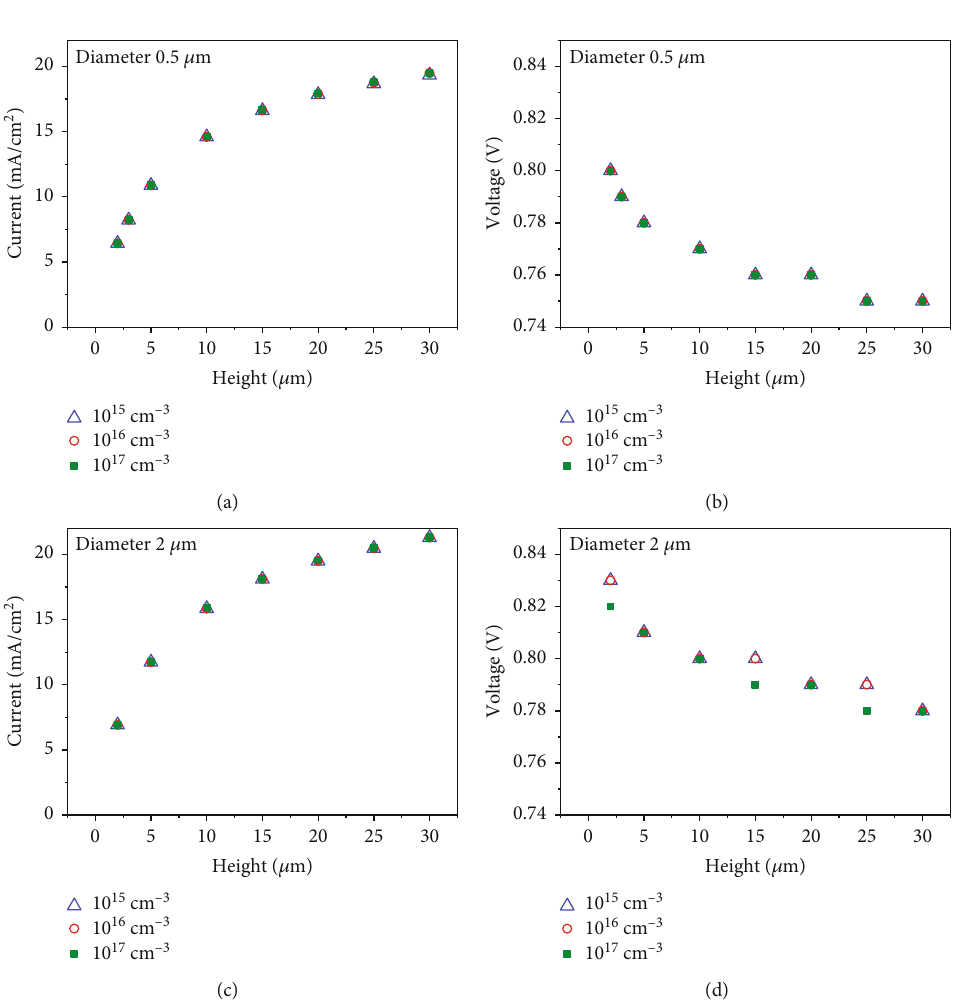
Figure 4: Calculated values of (a, c) J SC and (b, d) V OC for the bottom junction as a function of the height of silicon wires for the wire diameter of (a, b) 0.5 μ m and (c, d) 2 μ m and the MCC lifetime of 1